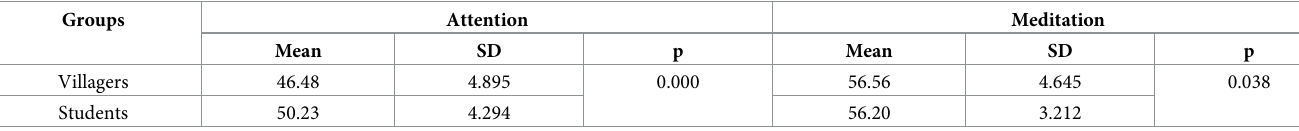
(p = 0.004 < 0.05) in students’ attention. The paper leaf (M = 51.45) is higher than the leather leaf (M = 50.30), contrary to the results for the villagers. But there is no difference (p = 0.566 > 0.05) between the two leaf textures. There is a significant difference (p = 0.017 < 0.05) in villagers’ attention on leaf lobes. The average value of leaves with leaf lobes (M = 47.05) is higher than that of leaves without leaf lobes (M = 45.30), which is consistent with students, but there is no difference (p = 0.260 > 0.05) in students’ attention (Fig 11). Flowers. The interaction effect between different living environment and all features of flowers with regard to attention and meditation is significant (p = 0.000 < 0.05). In different cators respectively (p < 0.05). Both groups have the highest attention on umbels, and the villag- higher attention on racemes, capitulums and cymes. In terms of meditation degree, the average value is higher in spica and catkin. Villagers and students also have a high degree of meditation in panicles and corymbs respectively. Furthermore, for the inflorescence types, there is only a significant difference in meditation degree between the two populations (p < 0.05), and the infinite inflorescence has the highest value, followed by solitary flower and limited inflores- cence. With regard to flower colours, there are significant differences between villagers and students in the two indicators respectively (p < 0.05). Villagers are more focused on pink, green and yellow, while the students are more focused on red, purple and green. In meditation, the villagers have the highest values of green, pink and white, while students have the highest val- ues for white, red and green in turn (Fig 12).